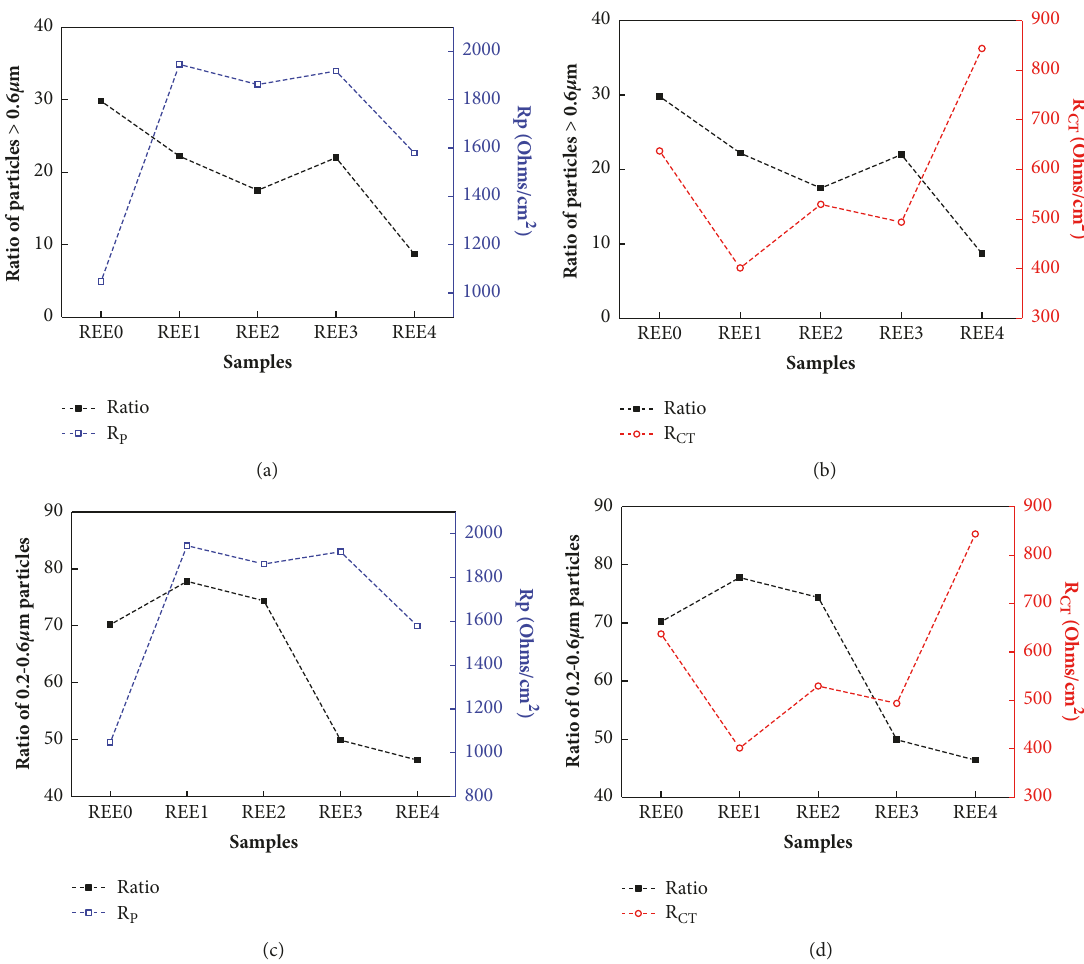
Figure 11: Correlation between second-phase particle sizes and the resistance in different welded